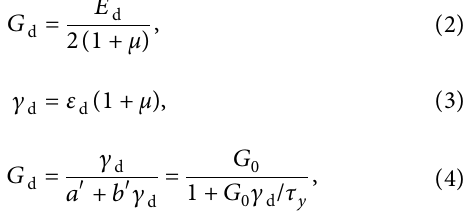
Table 4: Fitting parameters of G